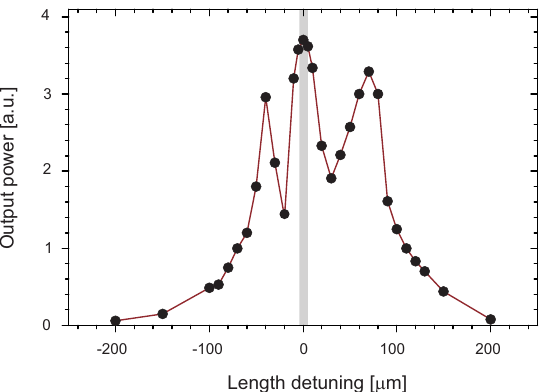
Figure 3. Dependence of the OPO signal power measured behind M6 ( R = 89% @ 1.5 µ m) on the length detuning of cavities. The area of stable mode locking is highlighted in gray.